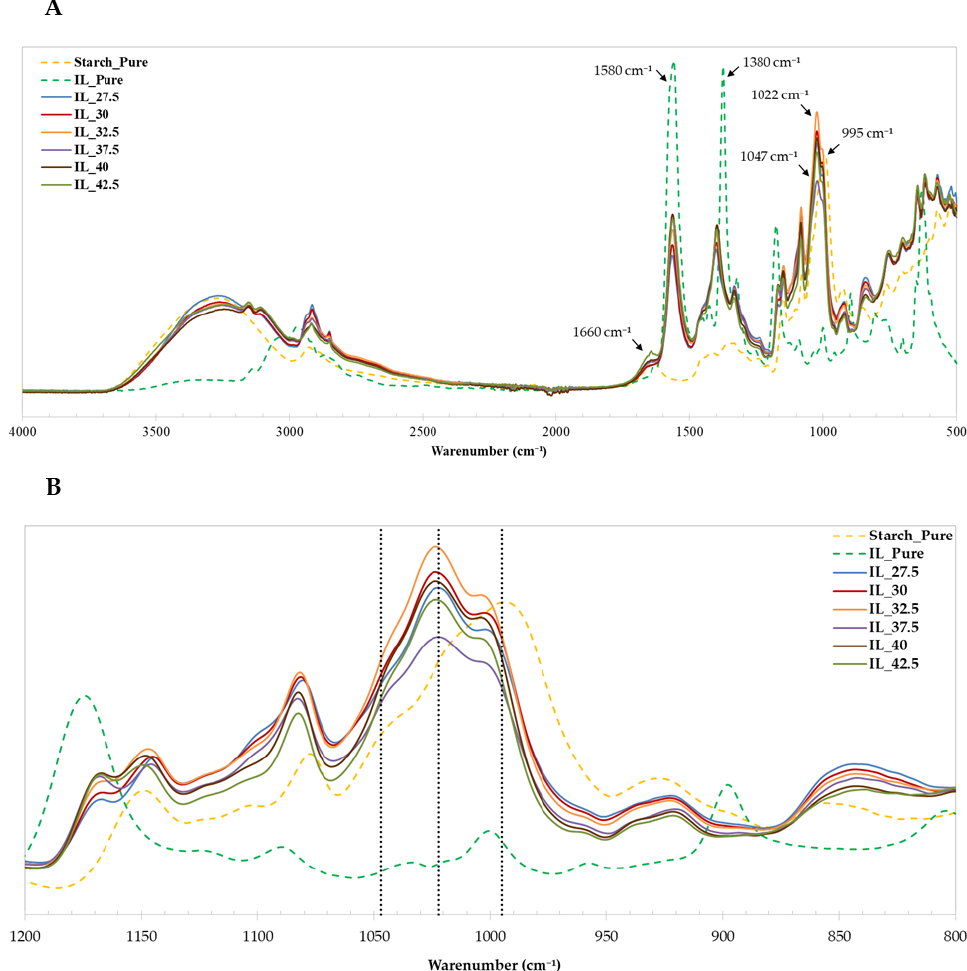
Figure 5. ATR-FTIR spectra of starch/PVA blends plasticized by [Emim + ][Ac − ]. ( A ) 500–4000 cm − 1 range; ( B ) 800–1200 cm − 1 range.